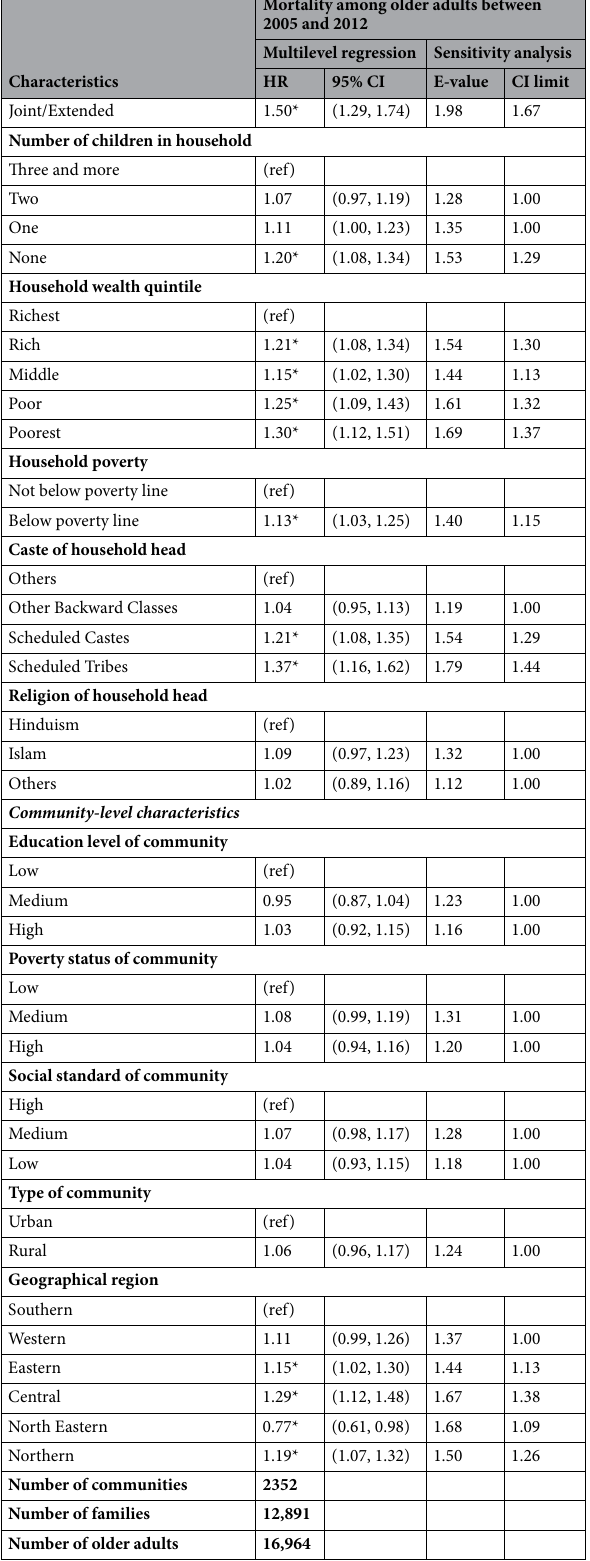
Table 5. Multivariate association between risk factors with mortality among older adults in India and sensitivity analysis of the determinants. (a) HR, hazard ratio; 95% CI, 95% confidence interval; (ref), reference category; (b) Statistical significance is denoted by asterisk where *denotes p-value < 0.05; (c) CI limit denotes 95% confidence interval limit nearest to the null value of 1.00; (d) CI limit of E-values, whose 95% CI includes the null value, is 1.00 and is not statistically